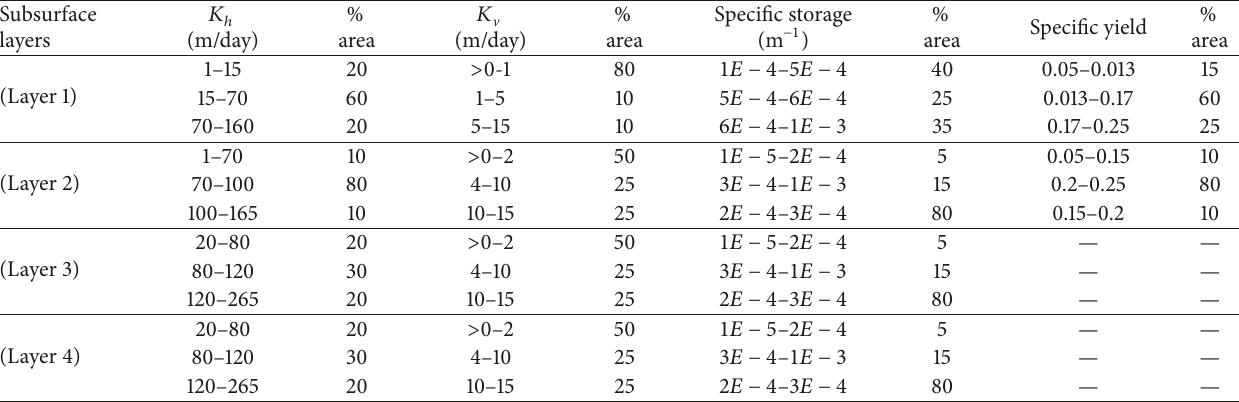
Table 1: Lithological data of all layers.